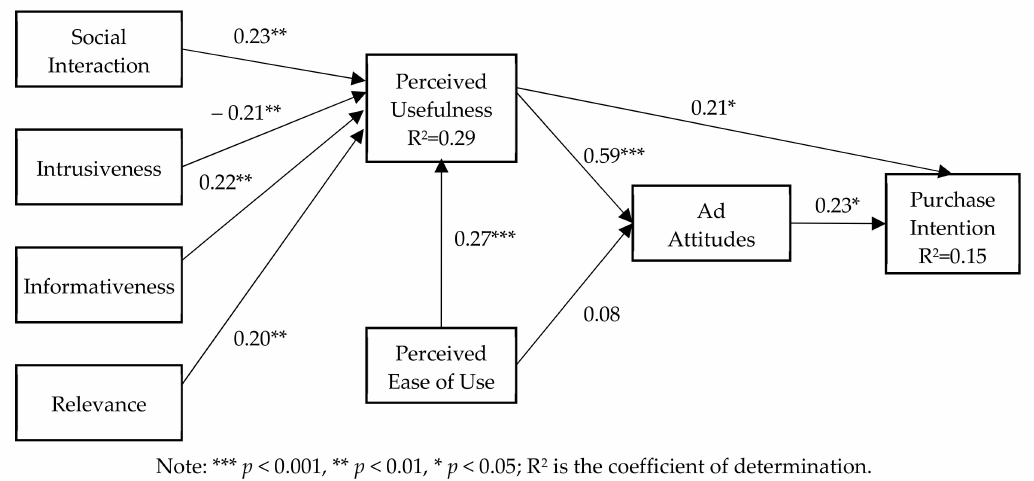
Figure 3. Results of structural model